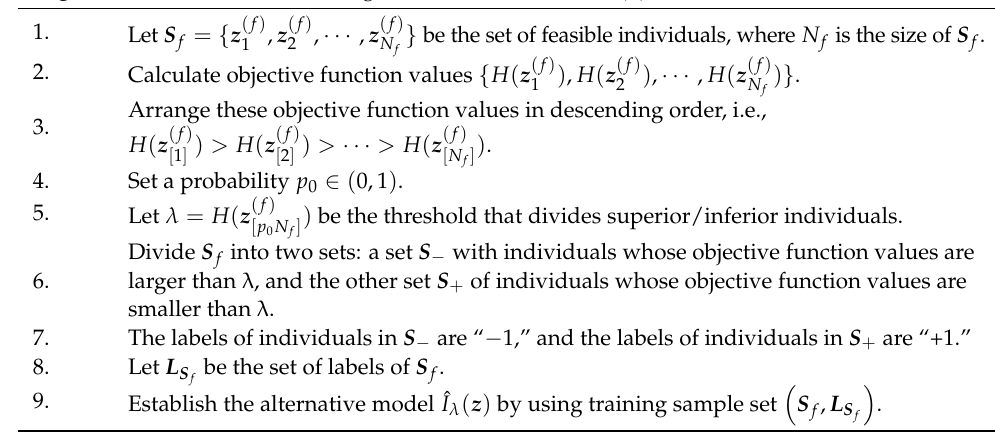
Algorithm 3 SVM for constructing the alternative model ˆ I λ ( z